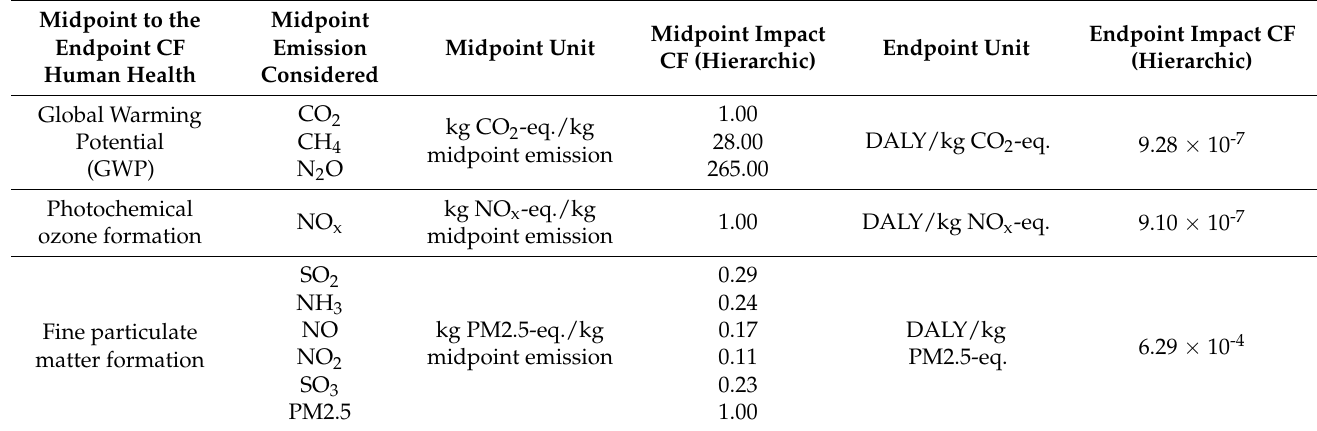
Table 12. Midpoint to endpoint characterization